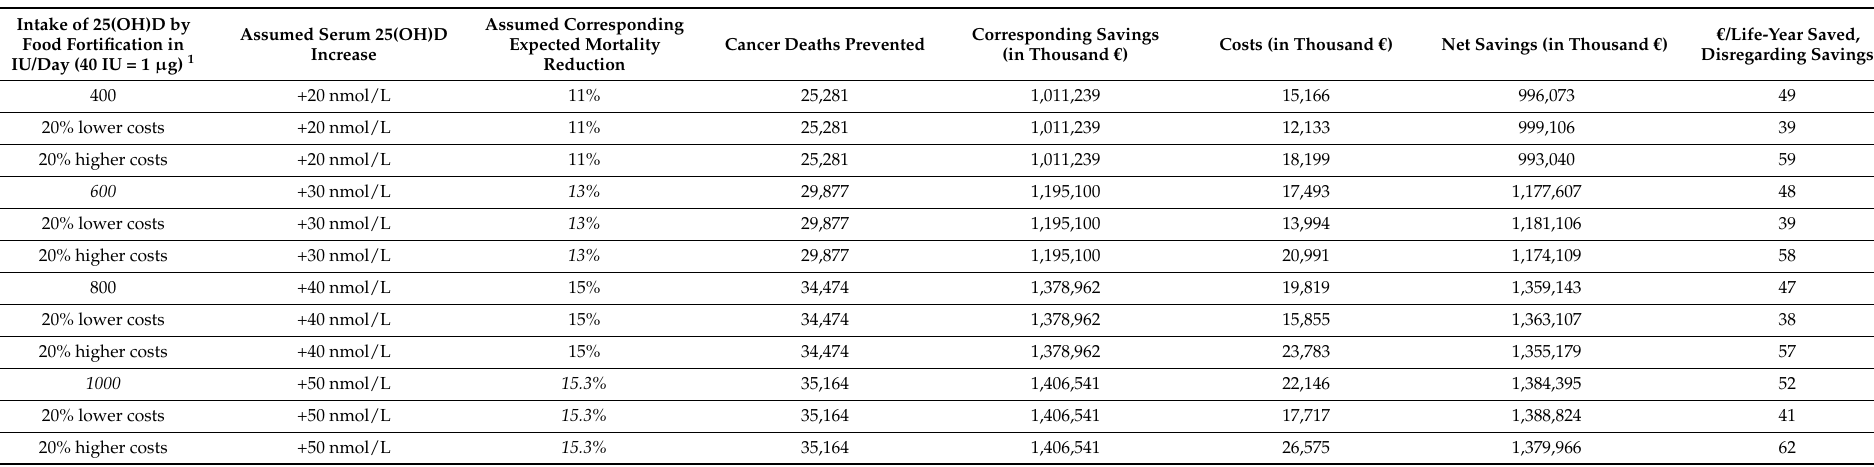
Table 5. Expected costs of and savings from vitamin D food fortification in Germany with respect to cancer mortality in